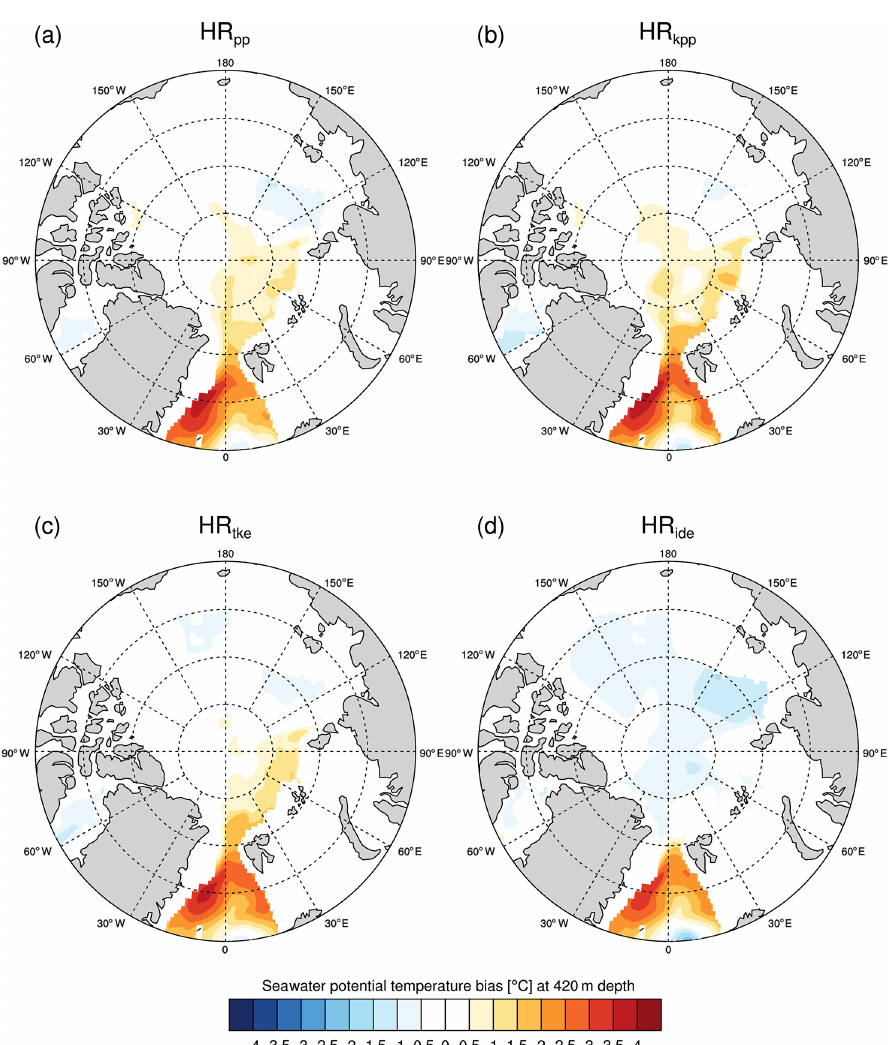
Figure 14. Time-averaged potential temperature bias of MPI-ESM1.2-HR minus EN4 (1945–1955) at a depth of 420m in the Arctic Ocean and the Fram Strait for (a) HR pp , (b) HR kpp , (c) HR tke , and (d) HR ide